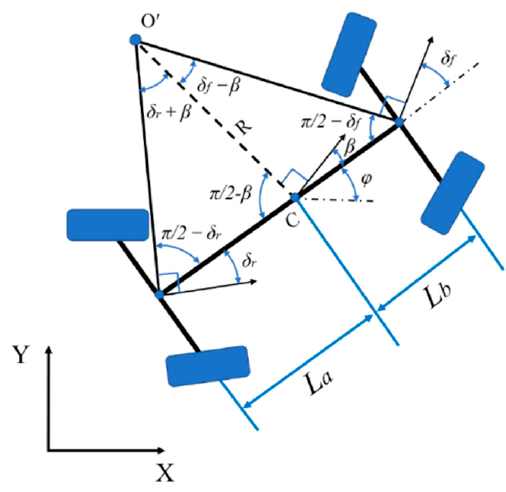
Figure 2. 4WS vehicle kinematics model .